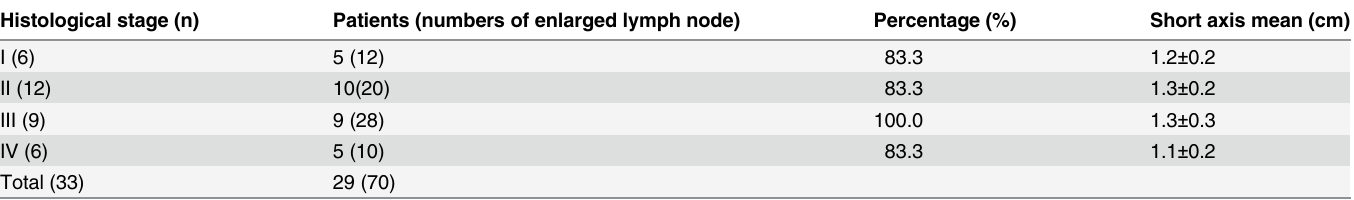
Table 5. The situation of lymphadenopathy at different histological stages.